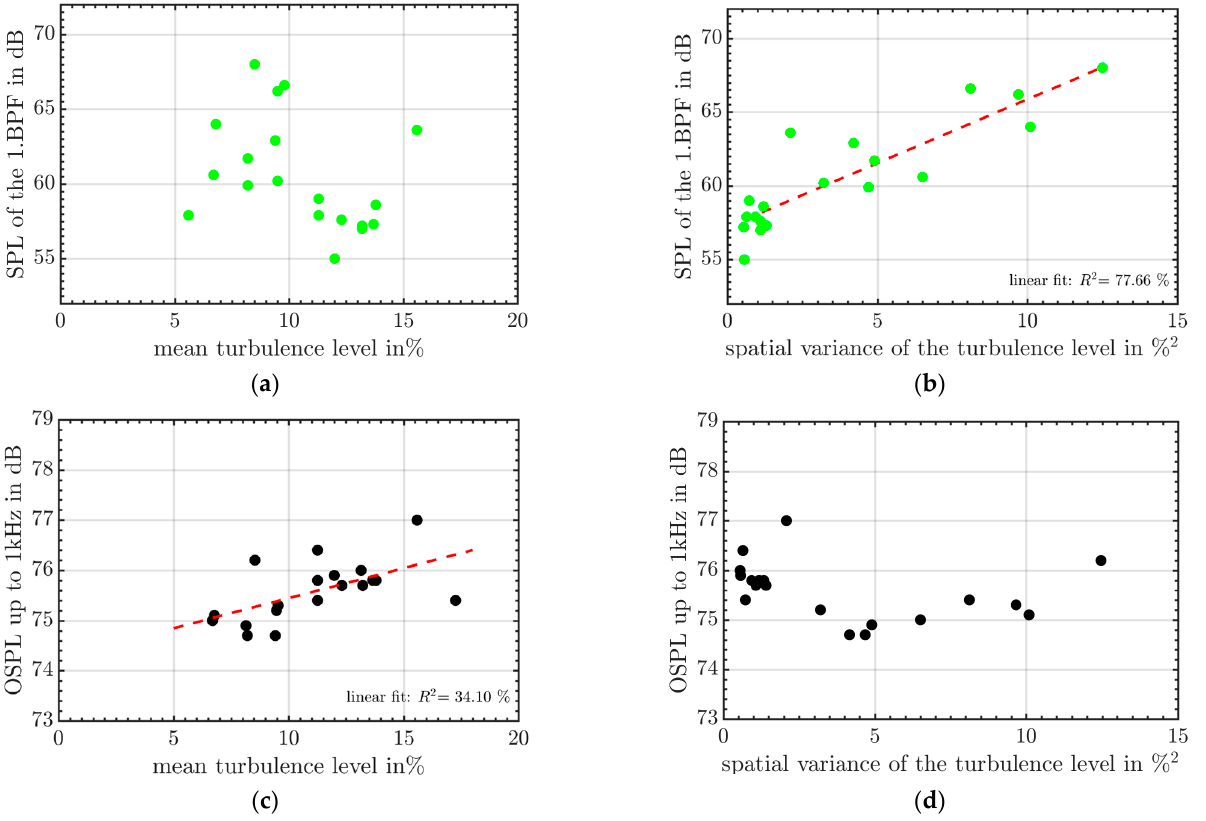
Figure 13. Influence of spatial mean turbulence intensity and spatial variance of turbulence intensity on sound radiation of axial fan at first blade passing frequency (1.BPF) and total sound pressure level between 0.1 kHz and 1 kHz. ( a ) BPF in dependence of the spatial mean value of the turbulence intensity, ( b ) BPF as a function of spatial variance of turbulence intensity with linear fit function, ( c ) BPF as a function of the spatial mean value of the turbulence intensity with linear fit function and ( d ) OSPL in dependence of the spatial variance of turbulence intensity.